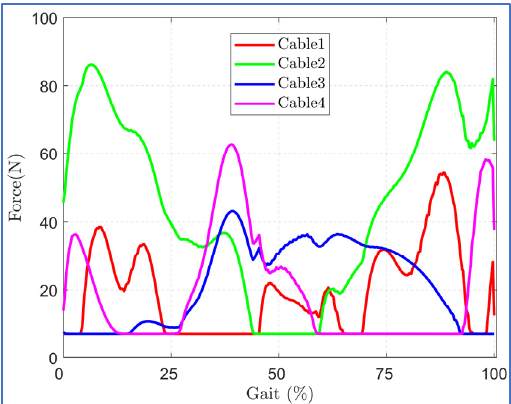
Figure 9. Cable Tension requirements in case (II) optimized cuff configuration.